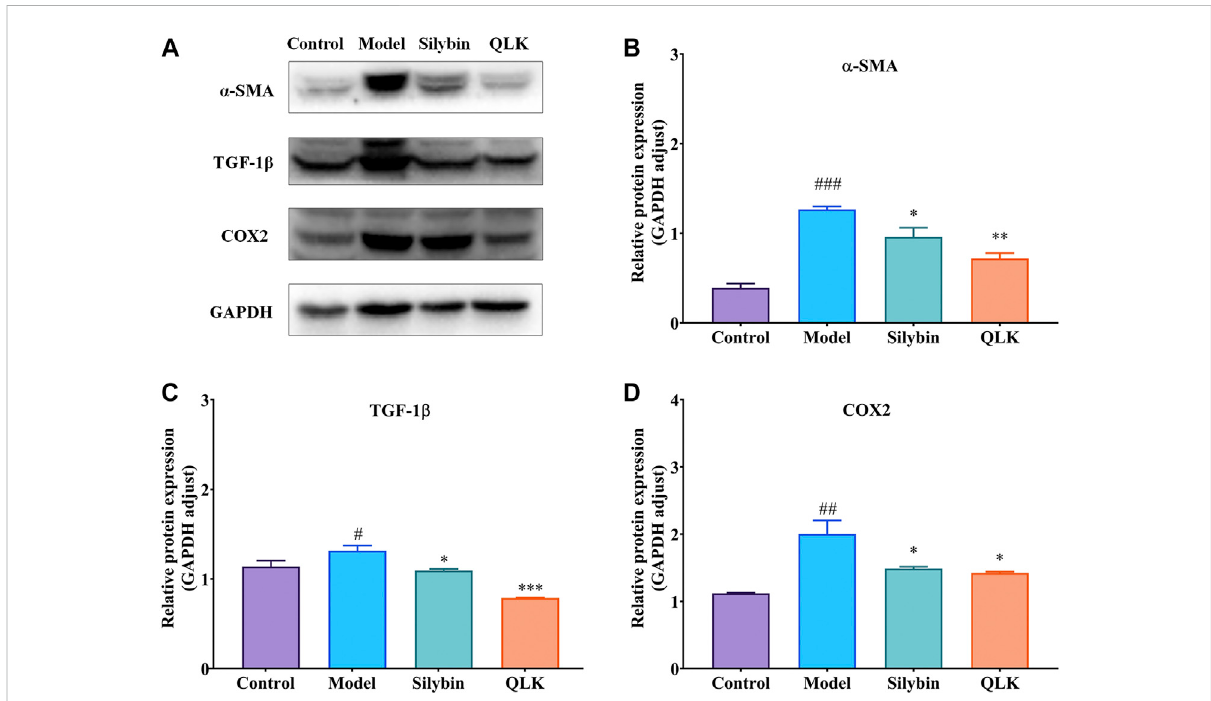
FIGURE 8 Western blot analysis for α -SMA, TGF-1 β , and COX2 protein levels in the liver of model rats ( n = 3). (A) Western blot analysis of α -SMA, TGF-1 β , and COX2 protein levels; (B) Relative protein of α -SMA was quantitatively expressed by densitometric analysis, GAPDH was served as an internal control; (C) RelativeproteinofTGF-1 β ; (D) RelativeproteinofCOX2.Valuesarepresentedasmean±SDforthreebiologicalreplicatespergroup.* p < 0.05, ** p < 0.01, *** p < 0.005 vs. model, # p < 0.05, vs. control, ## p < 0.01 vs. control, ### p < 0.005 vs. control. α -SMA, α -smooth muscle